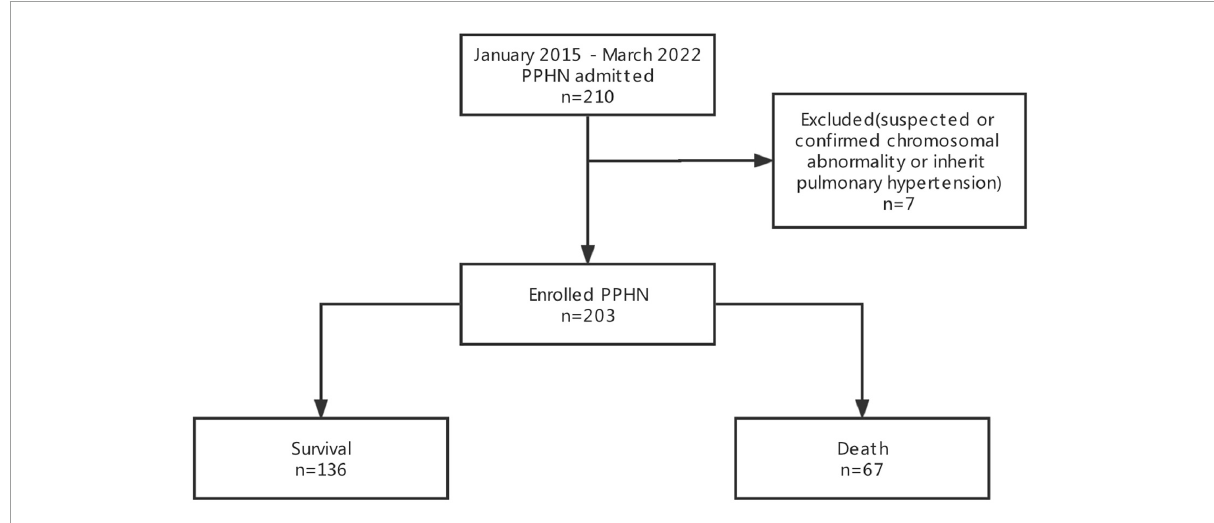
FIGURE1 A flow diagram of study participants.